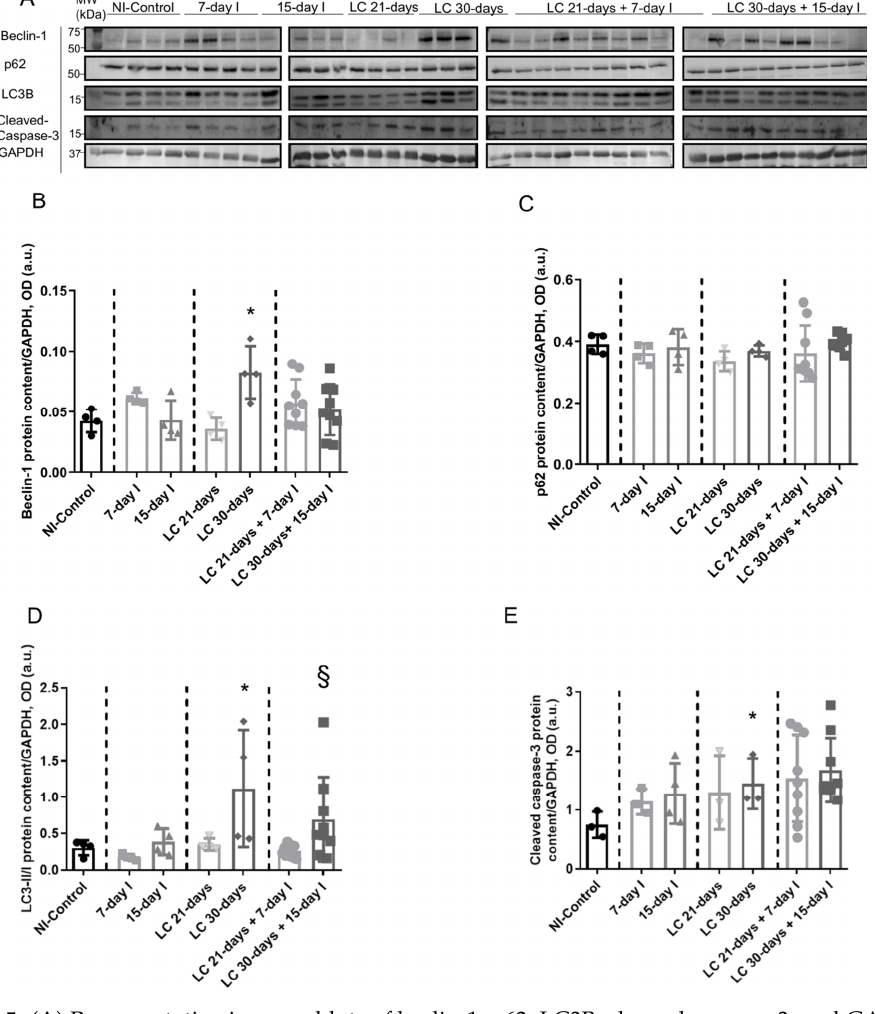
Figure 5. ( A ) Representative immunoblots of beclin-1, p62, LC3B, cleaved caspase-3, and GAPDH proteins in the gastrocnemius muscle of all study groups of mice. ( B ) Mean values and standard deviation of beclin-1 protein content in the gastrocnemius muscle of the different study groups of mice, as measured by optical densities in arbitrary units (OD, a.u.). Statistical significance is represented as follows: * p < 0.05 between 7-day I, 15-day I, LC 21-days, LC 30-days animals, and the NI-control mice. ( C ) Mean values and standard deviation of p62 protein content in the gastrocnemius muscle of the different study groups of mice, as measured by optical densities in arbitrary units (OD, a.u.). ( D ) Mean values and standard deviation of LC3B protein content in the gastrocnemius muscle of the different study groups of mice, as measured by optical densities in arbitrary units (OD, a.u.). Statistical significance is represented as follows: * p < 0.05 between 7-day I, 15-day I, LC 21-days, LC 30-days animals, and the NI-control mice; § p < 0.05 between any group of unloaded mice and their respective group of mice bearing the two conditions (LC-cachexia and unloading). ( E ) Mean values and standard deviation of cleaved caspase-3 protein content in the gastrocnemius muscle of the different study groups of mice, as measured by optical densities in arbitrary units (OD, a.u.). Statistical significance is represented as follows: * p < 0.05 between 7-day I, 15-day I, LC 21-days, LC 30-days animals, and the NI-control mice. Definition of abbreviations: p62, nucleoporin 62; LC3B, light chain